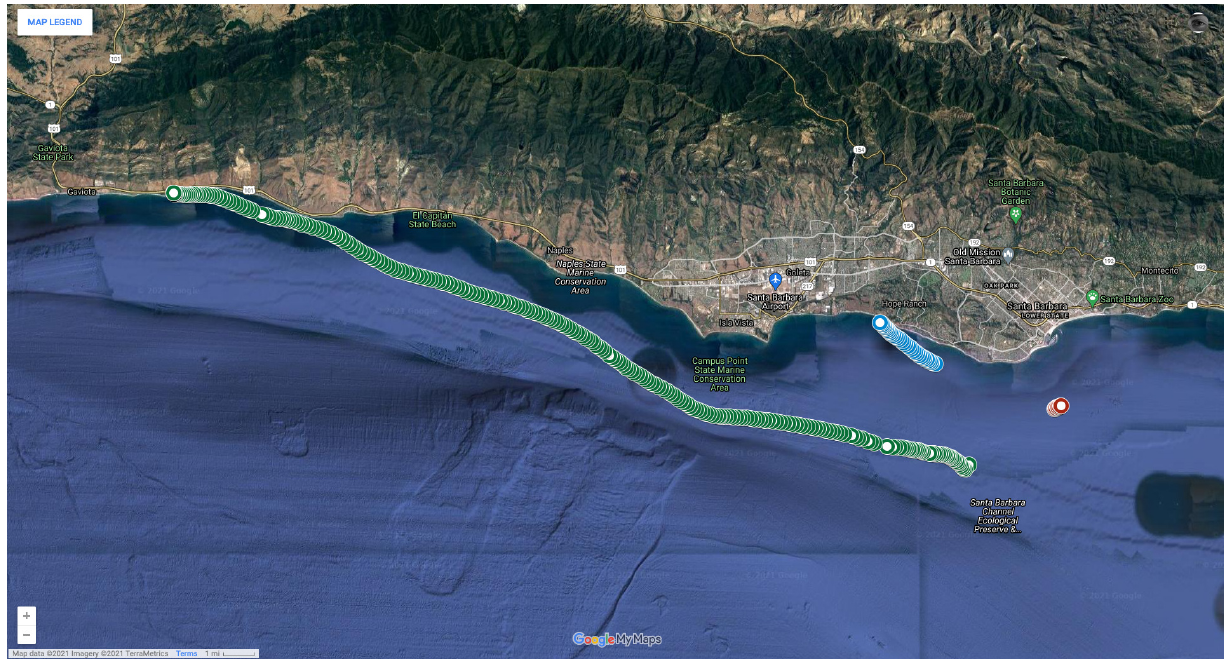
Figure 1: The three deployments of the MiB [Message in a Bottle] Google Maps screenshot by S.